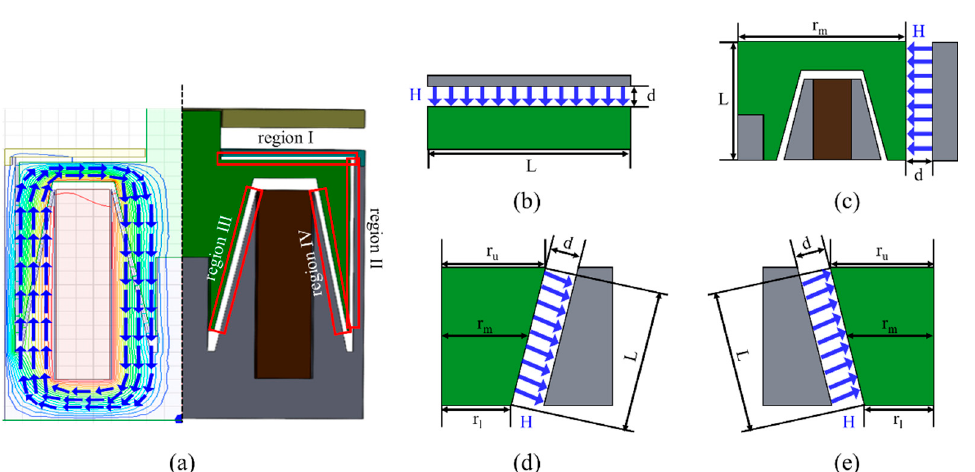
Figure 6. Parametric setup of the proposed haptic knob: ( a ) Cross-sectional view of the proposed haptic knob (left: the magnetic simulation result, right: four activation regions in the knob); ( b ) enlarged picture of region I; ( c ) enlarged picture of region II; ( d ) enlarged picture of region III; and ( e ) enlarged picture of region IV.